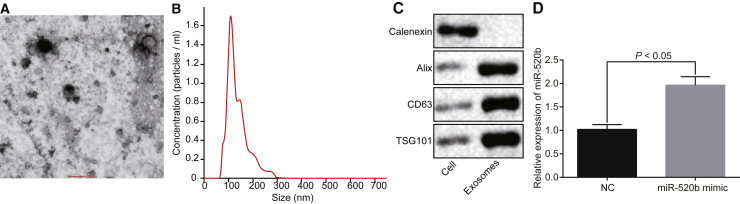
Exosomes Containing miR-520b Could Be Produced by NFs(A) The ultrastructure of exosomes produced by NFs observed under the TEM (×5,000). (B) The size-distribution profile of exosomes by nanoparticle tracking analysis. (C) The expression of exosome markers CD63, Alix, TSG101, and negative marker calnexin, confirmed by western blot analysis. (D) miR-520b expression in the exosomes determined by qRT-PCR. Data in the figure were analyzed by independent-sample t test. The experiment was repeated 3 times independently.